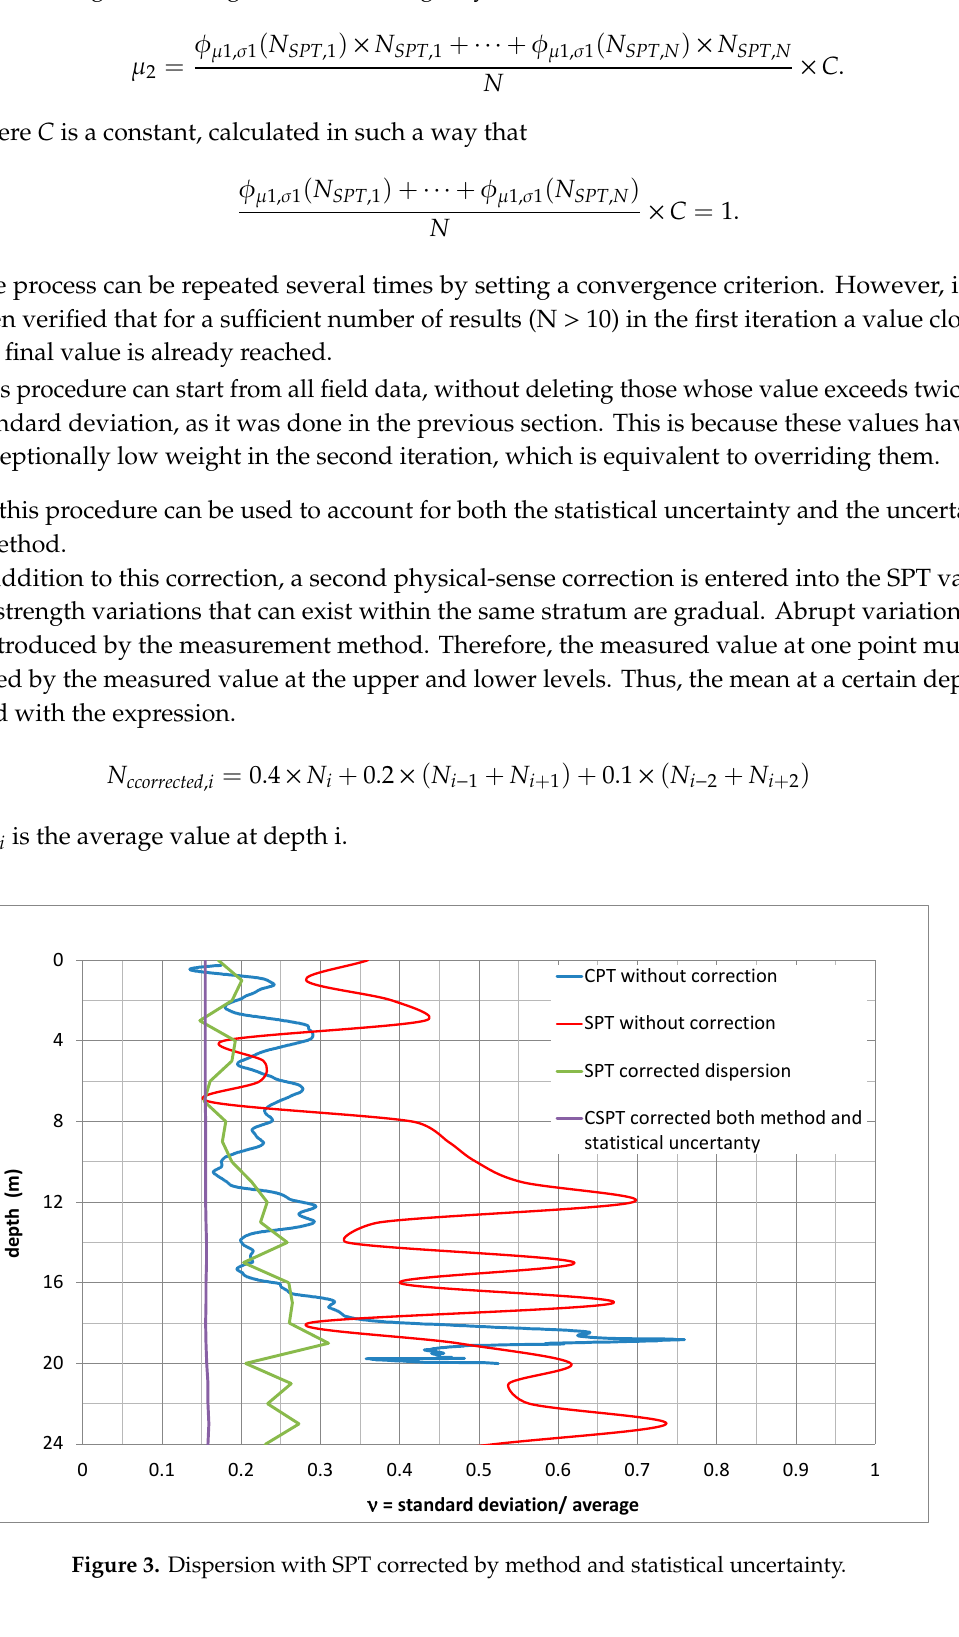
( b ) Figure 4. N SPT representation: ( a ) Example of a statistical representation of the SPT-parameter corrected by method and statistical uncertainty; ( b ) Artificial SPT profile generated by probabilistic Monte Carlo Method.